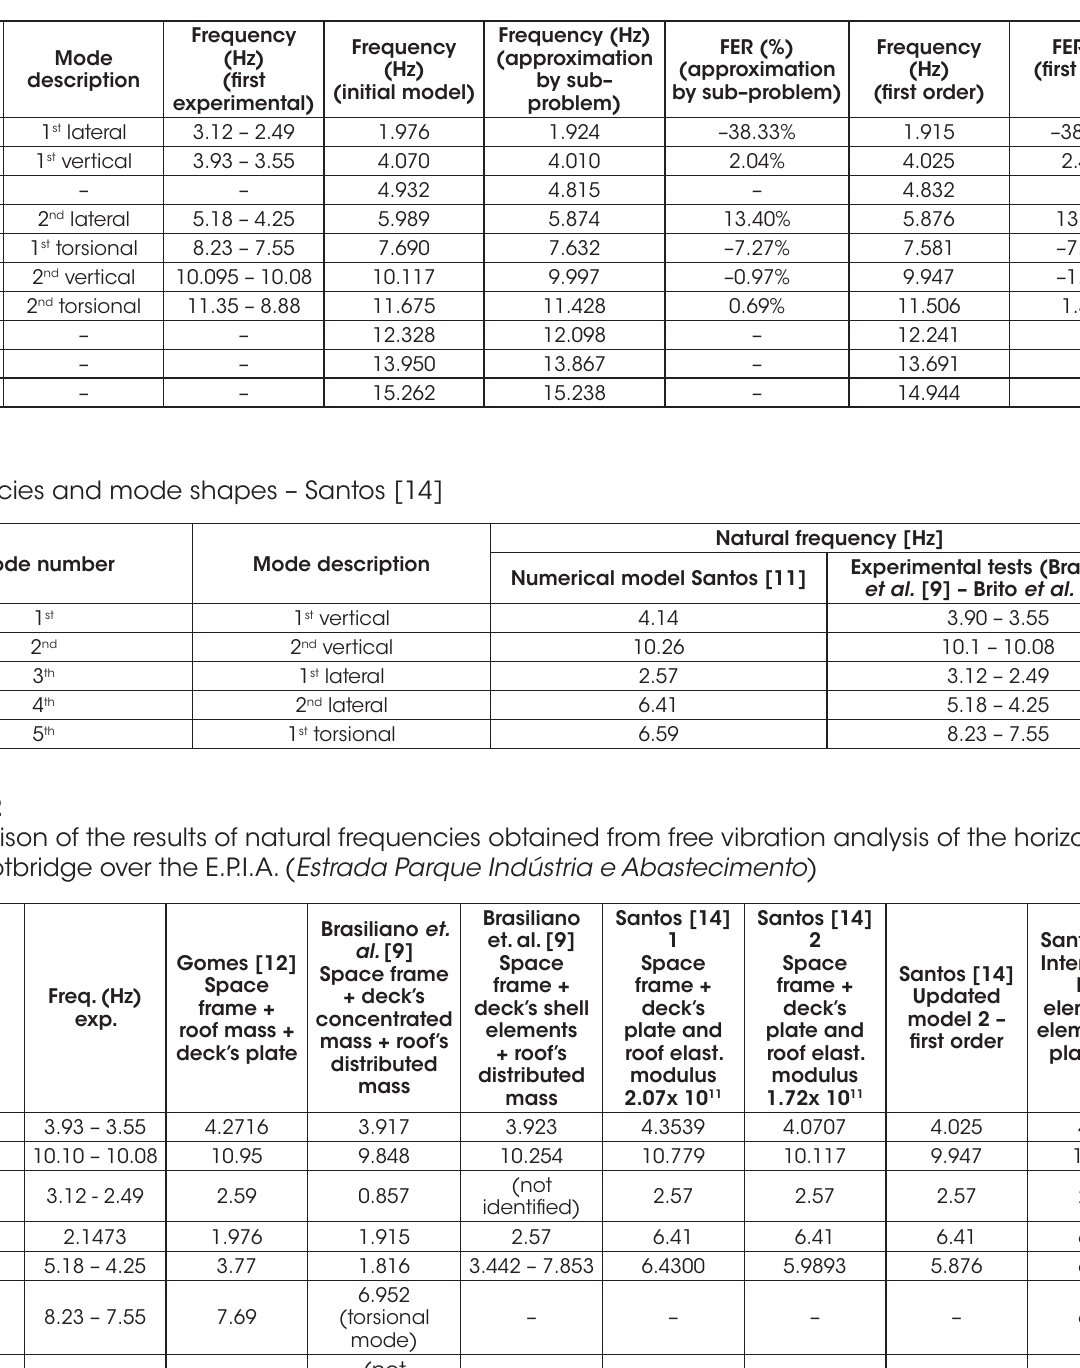
Experimental and numerical natural frequencies and FER indexes to the vertical modes numerical model